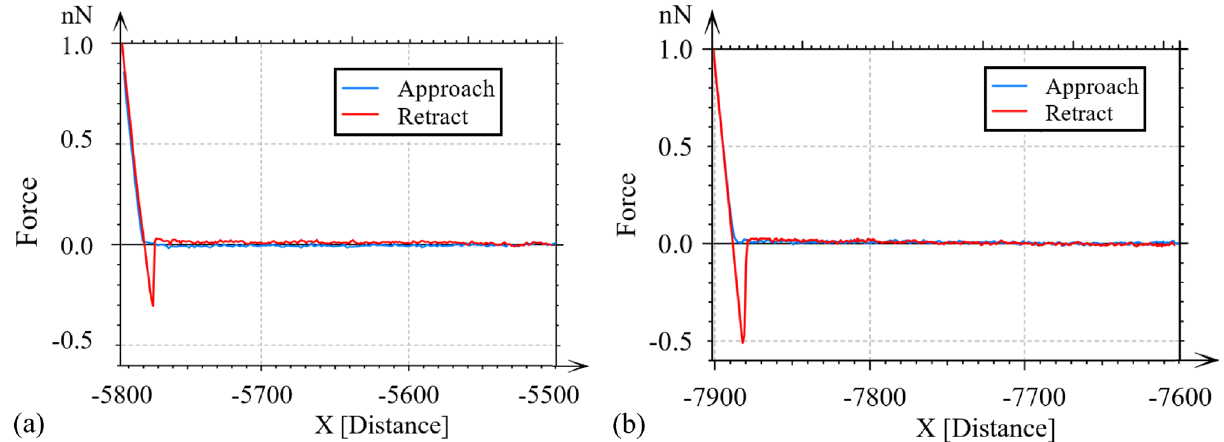
Figure 4. Examples of force-distance curves for struvite faces ( a ) (001) and ( b ) (00 1 ) in artificial urine. For the presented curves, the values of the adhesive force for faces (001) and (00 1 ) are equal to: 0.30 nN and 0.51 nN,